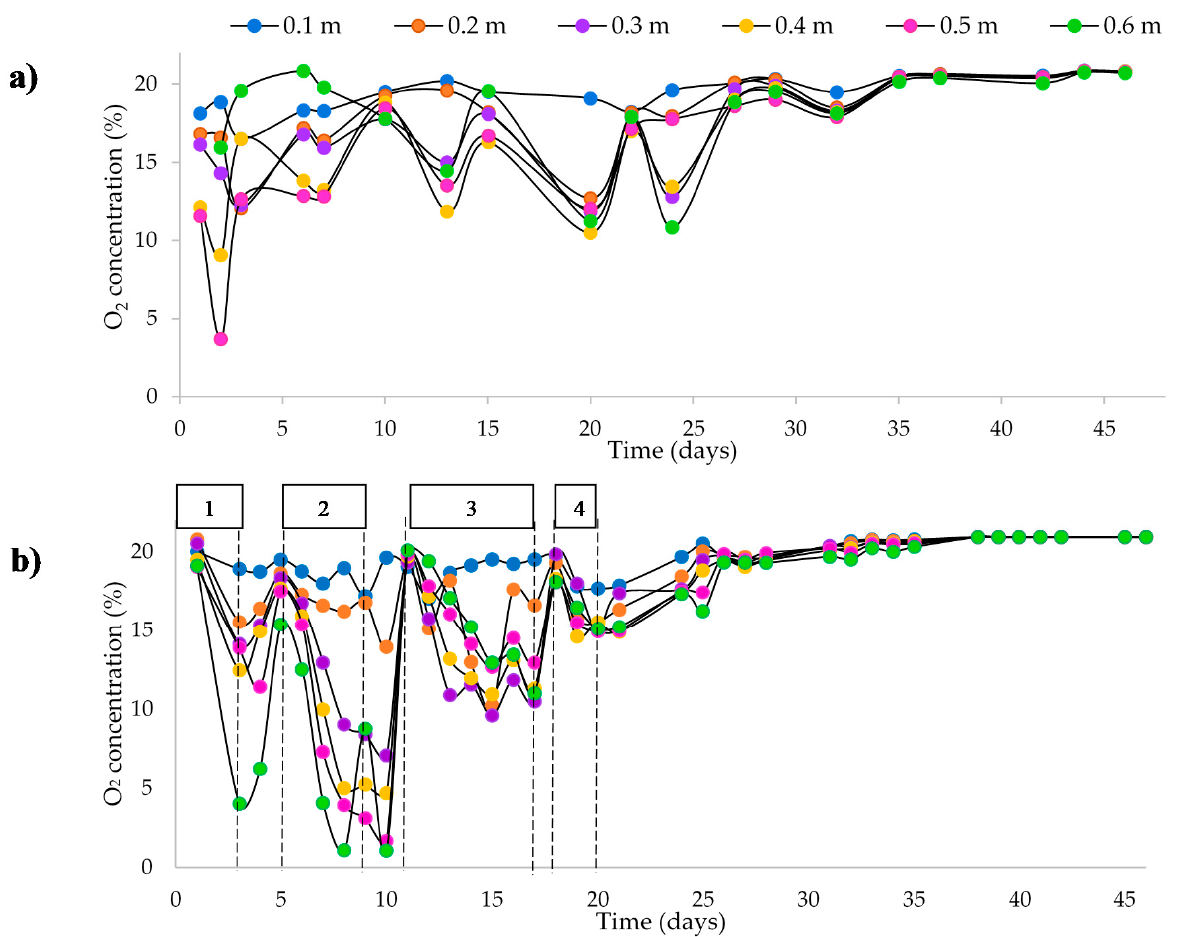
Figure 3. Percentage of O 2 at different depths (0.1, 0.2, 0.3, 0.4, 0.5 and 0.6 m) of ( a ) pile P1 and ( b ) pile P2 during the biodrying process.